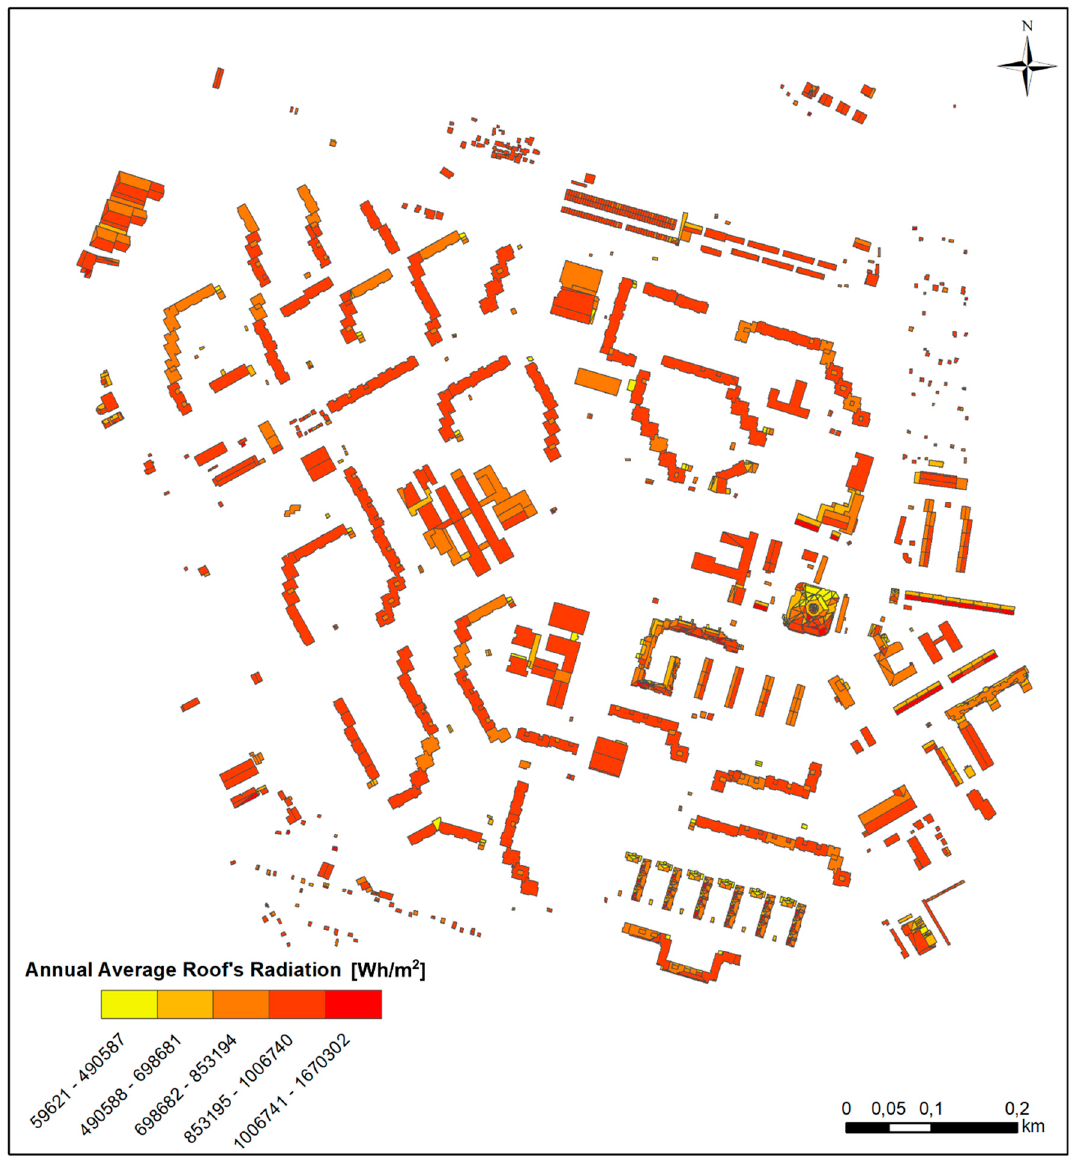
Figure 5. The results of the SOLIS assessment—sample B.